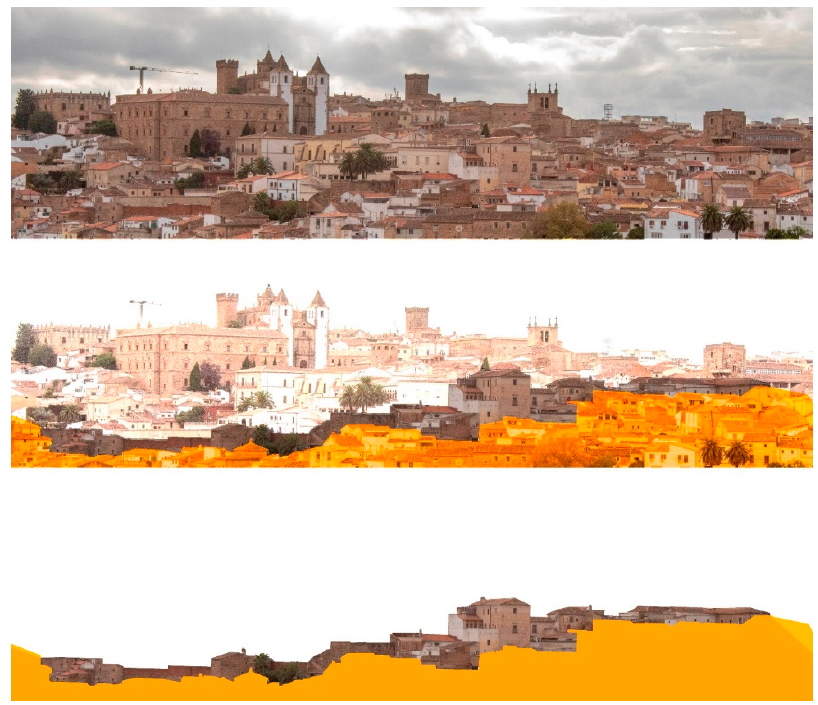
Figure 3. Location of the intervention within the defensive line currently absorbed by existing buildings. View from the Cerro de la Butrera.